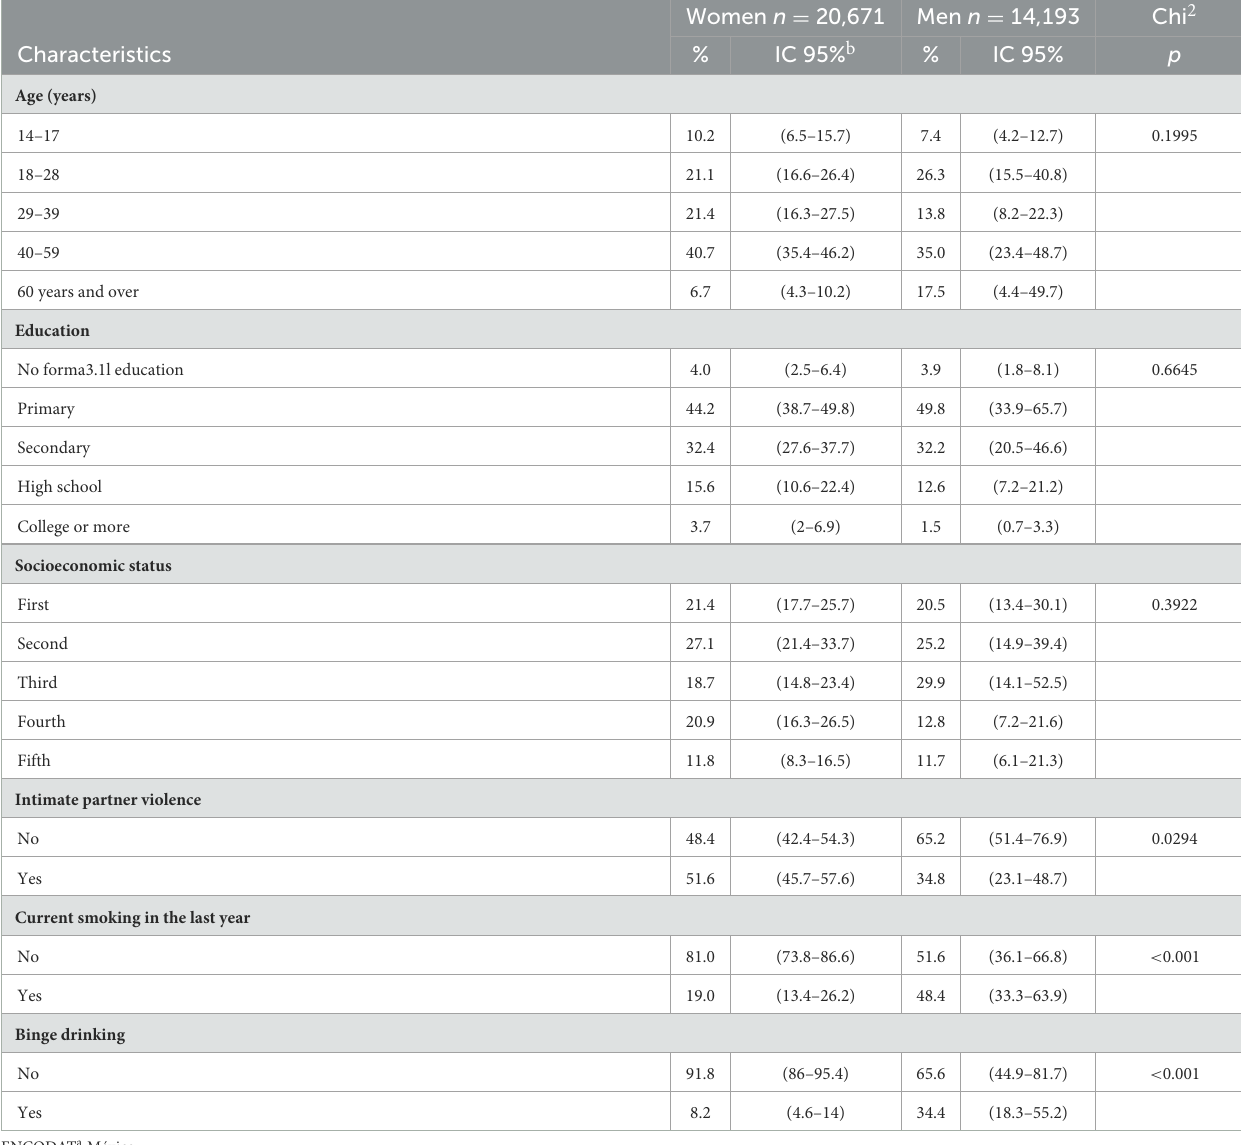
TABLE 2 Study population psychological